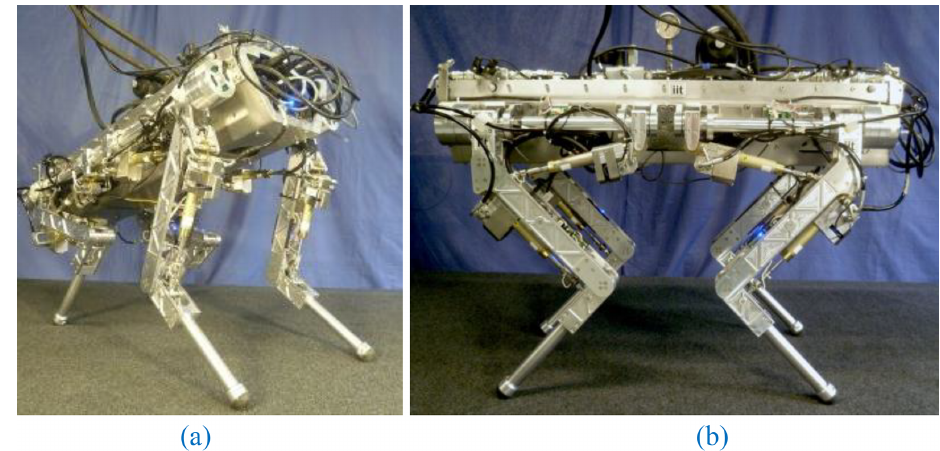
Figure 1. Physical images of a hydraulic four-legged robot. (a) In 2012, robot images with stereo cameras were not installed. (b) In 2012, robot images with stereo cameras were